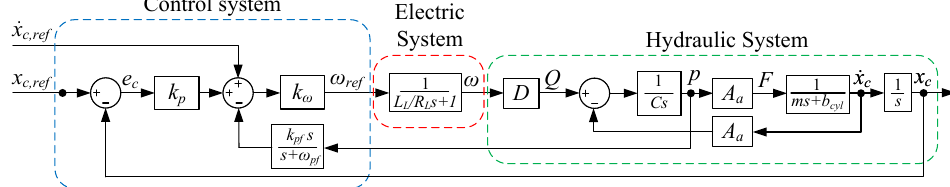
Figure 13. Closed-loop linear model of the